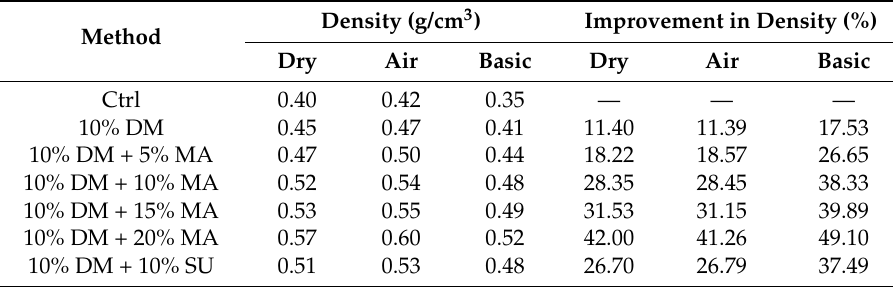
Table 3. Changes in the density of wood treated with different